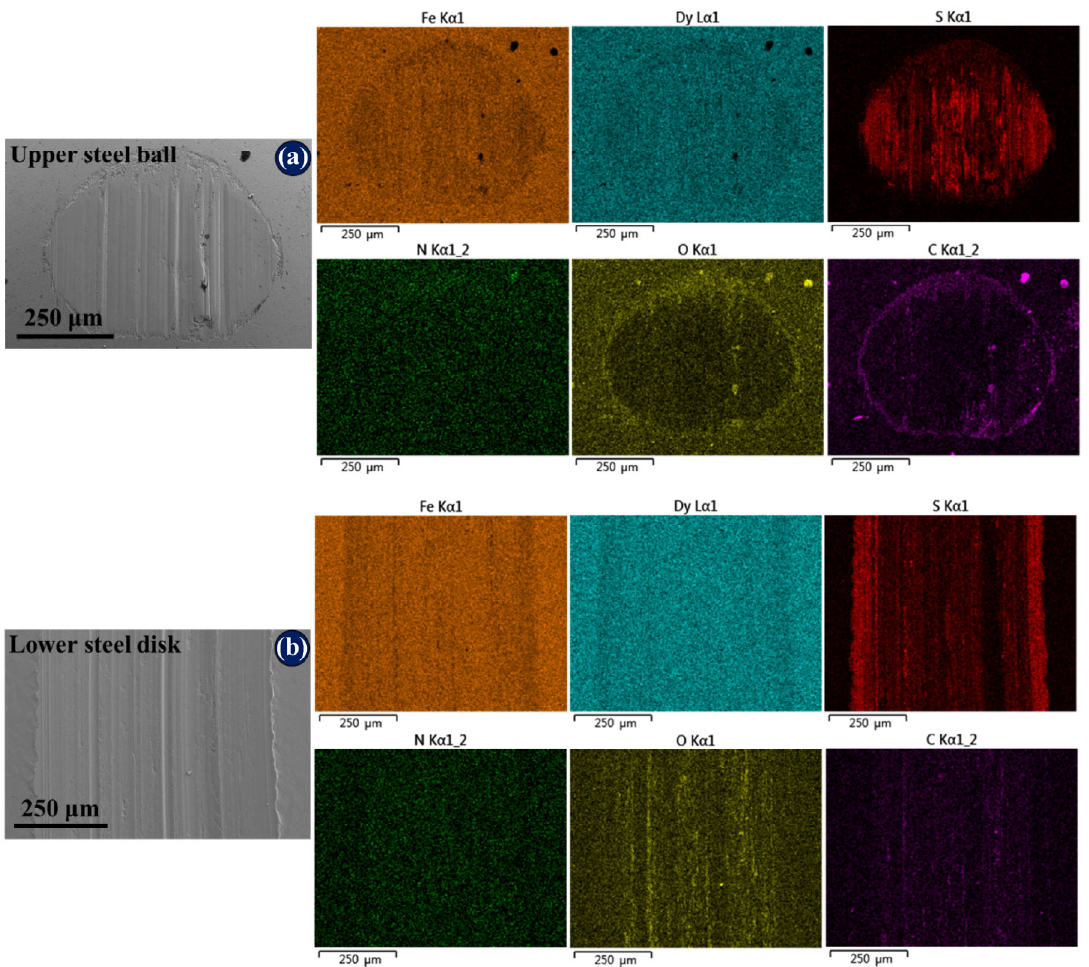
Fig. 13 SEM micrographs and EDS analysis of worn surfaces of an (a) upper steel ball and (b) lower steel disk under MIL lubrication at 100 N and 150 ° C.